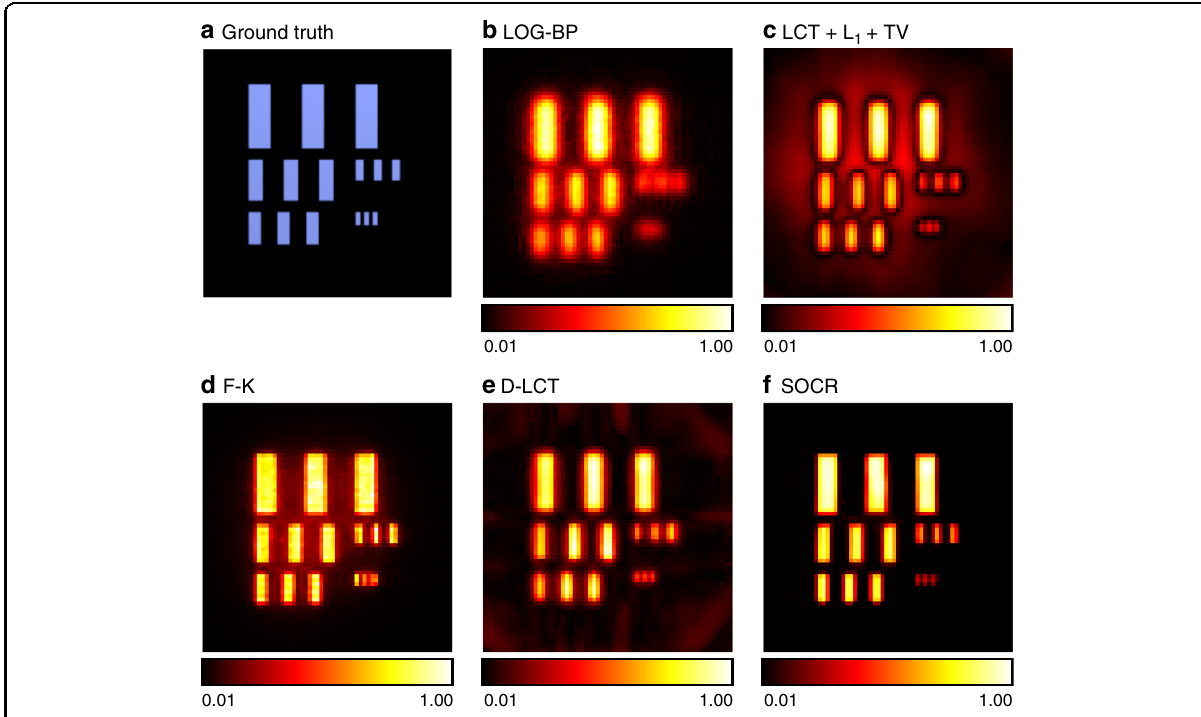
Fig. 3 Reconstruction results of the USAF (confocal). The ground truth is shown in a . Reconstructed albedo is shown in b - f . The proposed algorithm reconstructs the object with the best visual